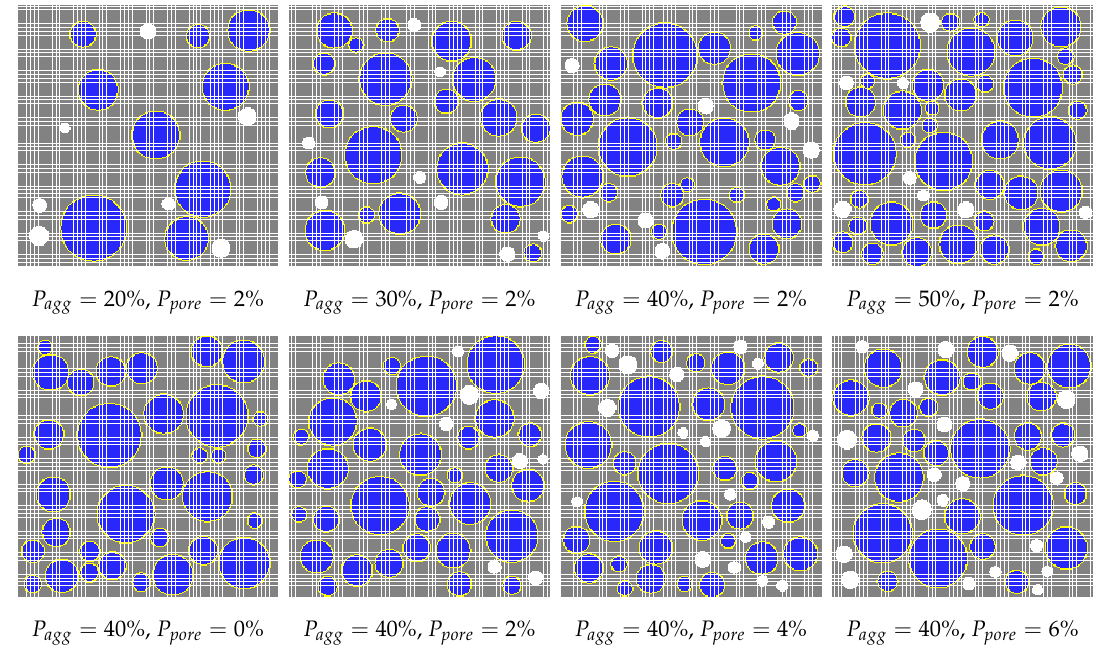
Figure 2. Numerical specimens with varying aggregate volume fraction and porosity.